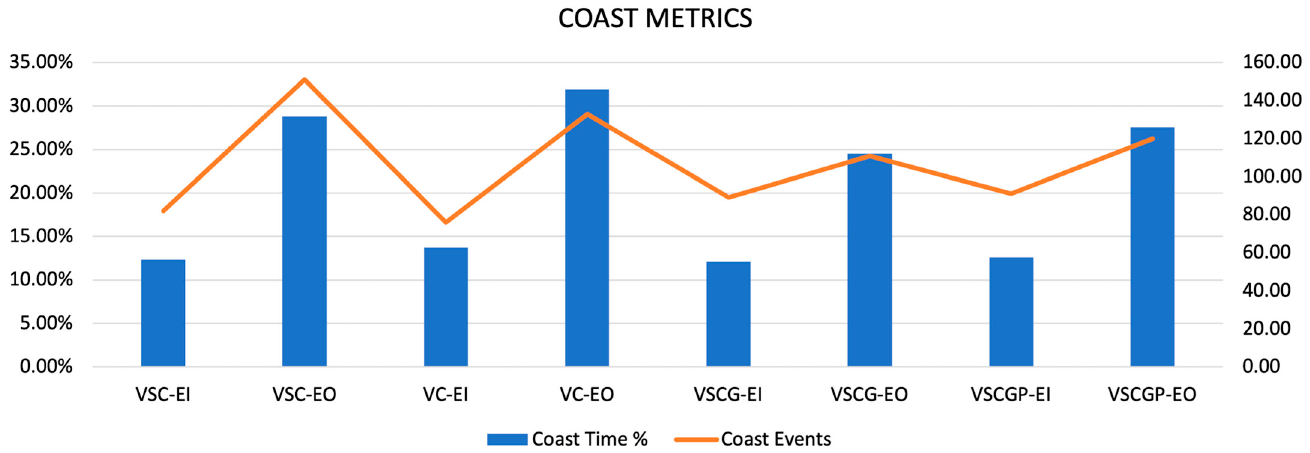
net fuel economy is not related to coast events alone but is a combined factor of multiple